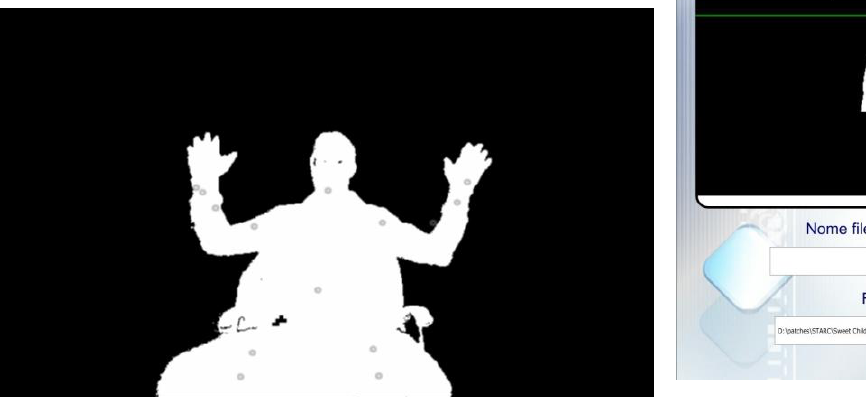
Figure 12. Posture rehabilitation